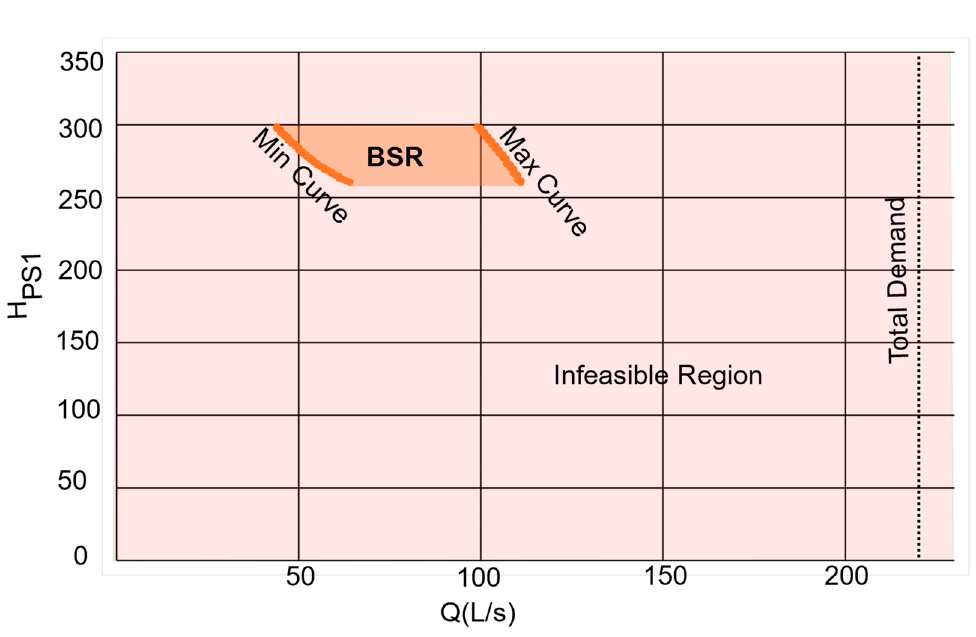
Figure 6. Calculated IM of PS 2.